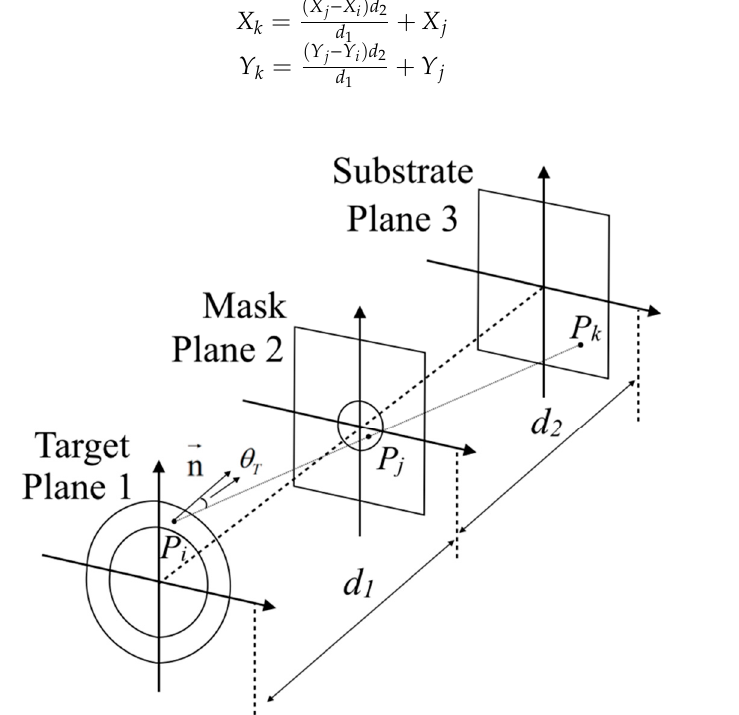
Figure 5. Schematic diagram of the straight-line transport of sputtered particles passing through the mask.